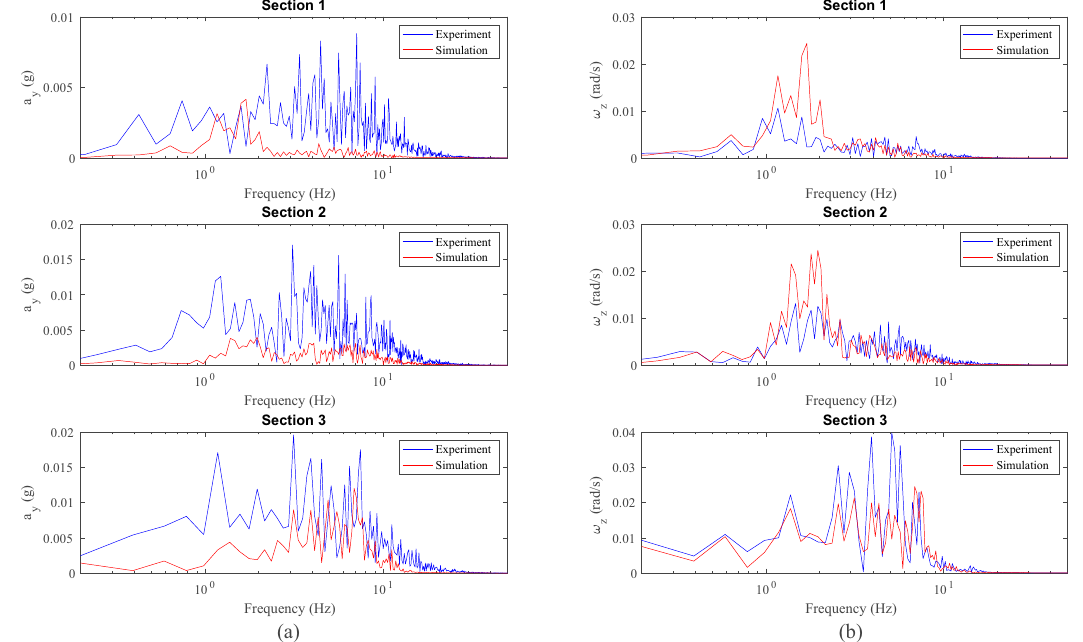
Figure 18. Frequency analysis of lateral acceleration ( a ) and yaw angular velocity ( b ) data from inertial sensors on the